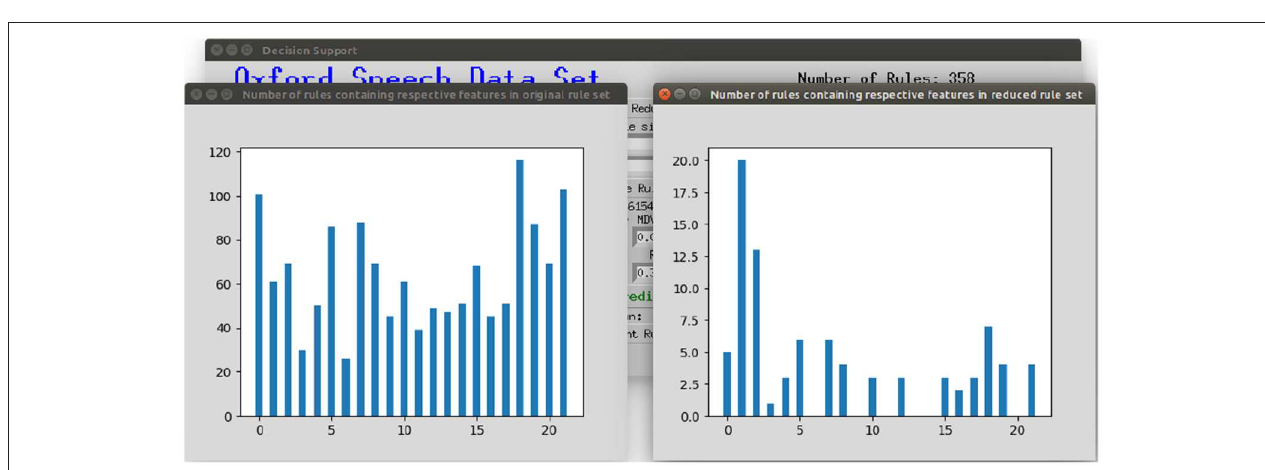
et al. (2000), and Humbird et al. (2018). Those two